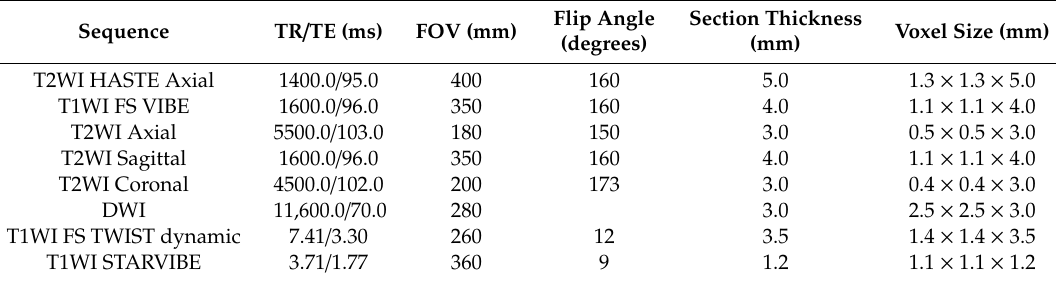
Table 4. Imaging parameters used for